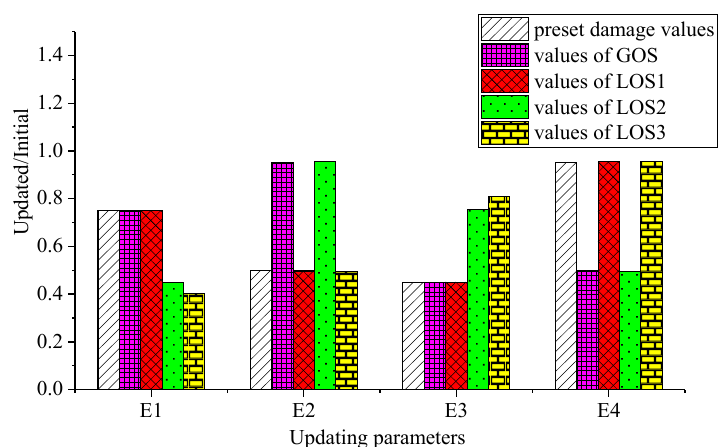
Figure 13. Ratio of parameters corresponding to each group of solutions to initial values.